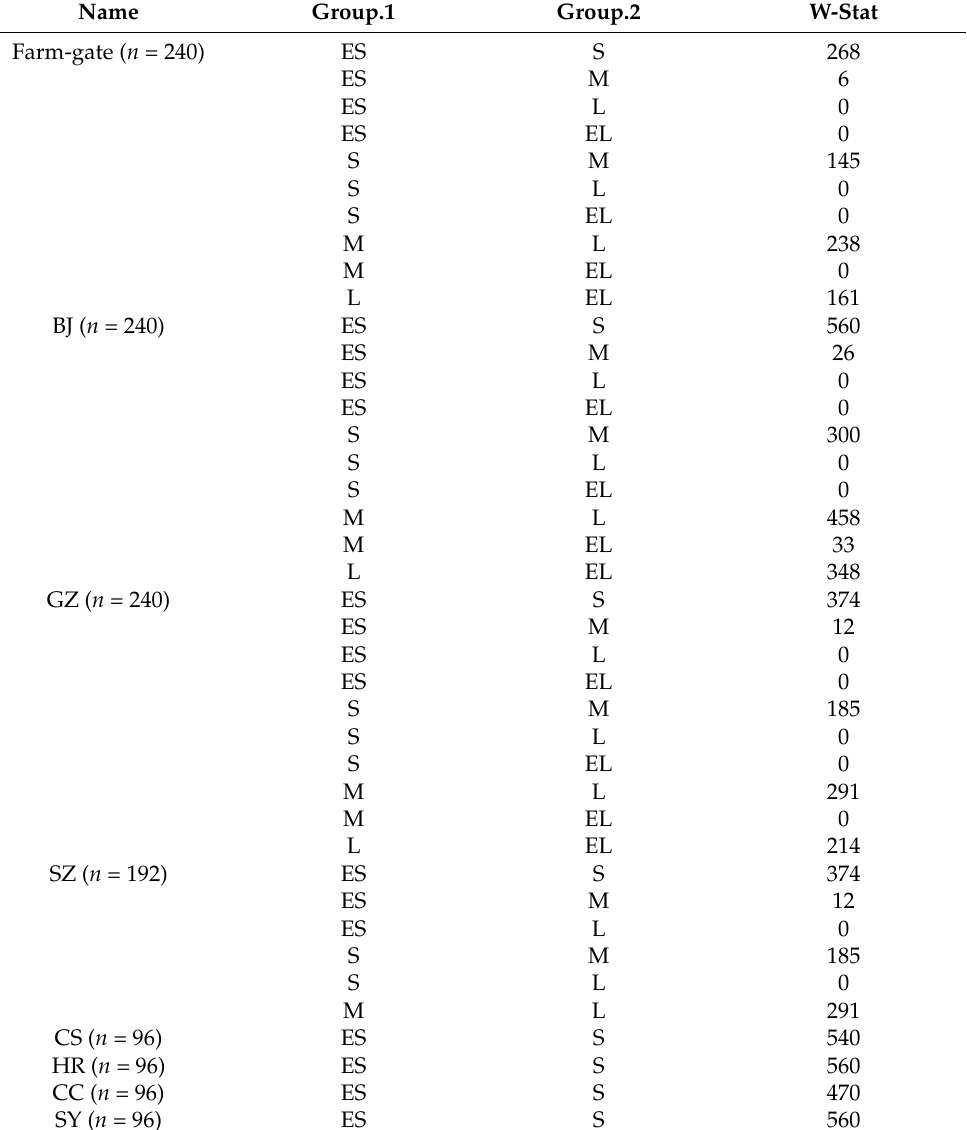
Table 4. The differences between specifications in the farm-gate group and the wholesale market group. Name Group.1 Group.2 W-Stat Farm-gate ( n = 240)